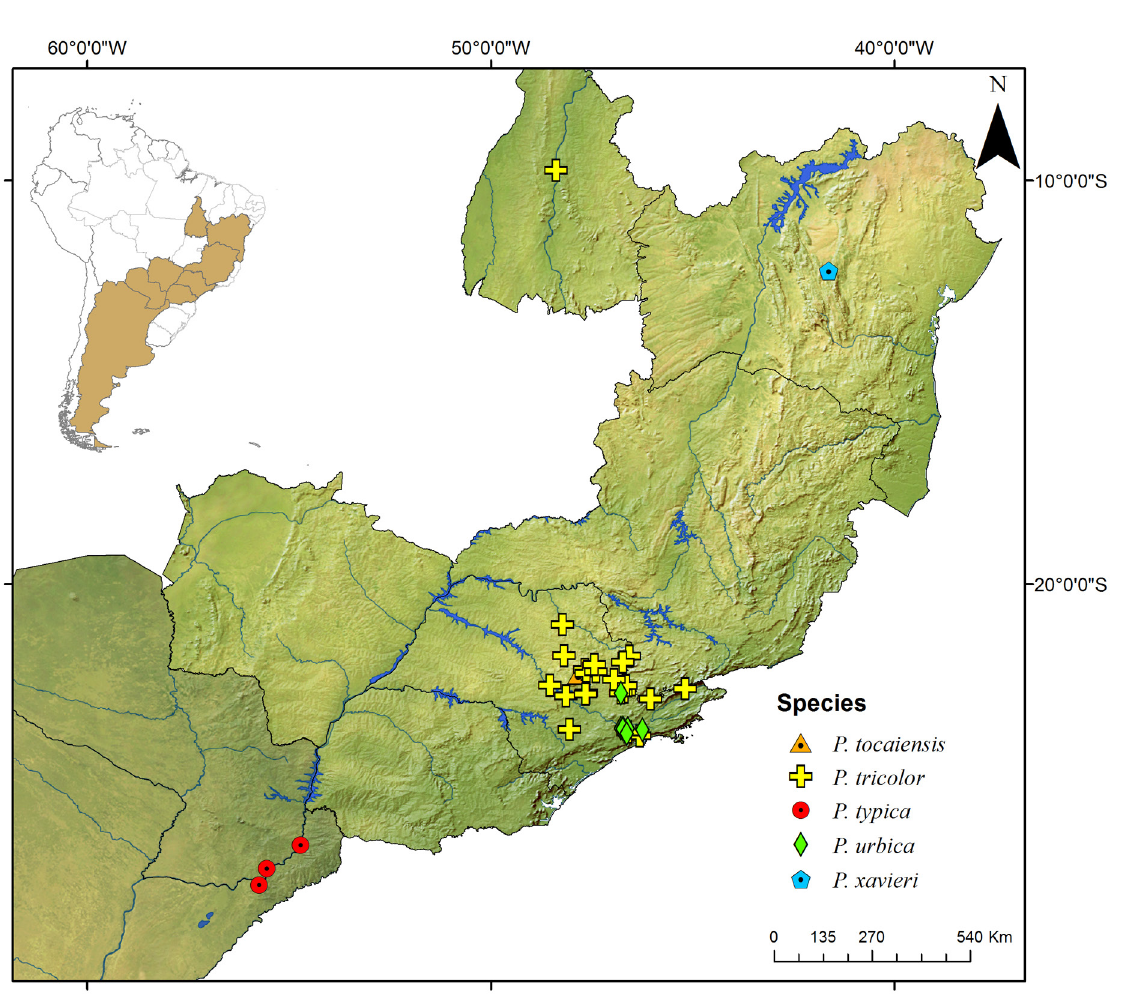
Fig. 189. Distribution map of the species Pseudonannolene tocaiensis Fontanetti, 1996, P.